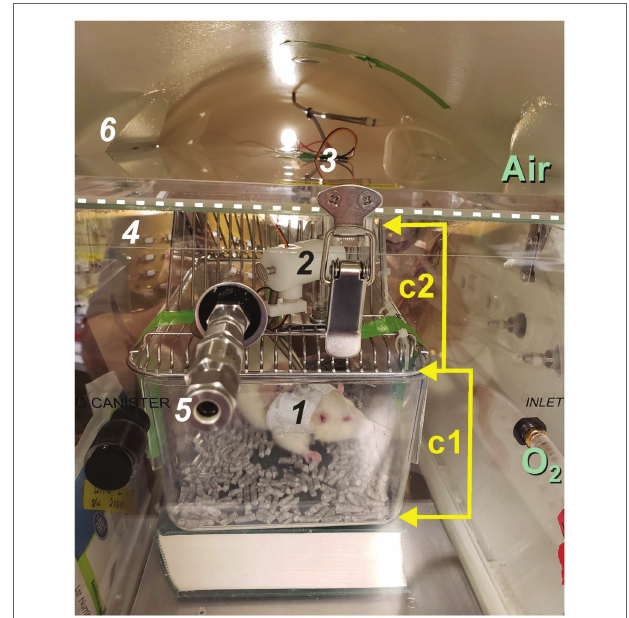
FIGURE 2 | The animal exposure chamber inside the hyperbaric chamber. The main hyperbaric chamber houses the animal exposure chamber, which contains the animal cage (c1) and wire cage lid (c2). The main chamber is compressed using air only while the animal exposure chamber is ventilated with either air at 1 ATA (control) or 100% O 2 at 1 or 5 ATA (hyperoxia). In this experiment, the front edge of the lid to the animal exposure chamber is demarcated by the horizontal white dashed line; one of six buckles used to seal the cover of the animal exposure chamber is seen here. A preset pressure relief valve (5) prevents over-pressurization of the animal exposure chamber during the experiment. Other important items seen here include the animal’s jacket and tether (1) that passes up through an opening in the wire cage lid (c2) and connects to the moveable tether assembly (2) mounted on the cage lid (c2). The two, needle electrode leads pass upwards through the tether cable to the tether assembly (2), exit through the roof the animal exposure chamber (3), and plug into the internal electrical connector panel behind the animal exposure chamber (4). The welded window port (6) is barely visible in this image through which the animal’s behavior is monitored continuously using a video camera. This animal was not implanted with a radio telemetry module; however, if it was the receiver would have been stood on its side and resting against the exterior of the animal exposure chamber. Cabling for the telemetry receiver then plugs into the internal electrical connector panel